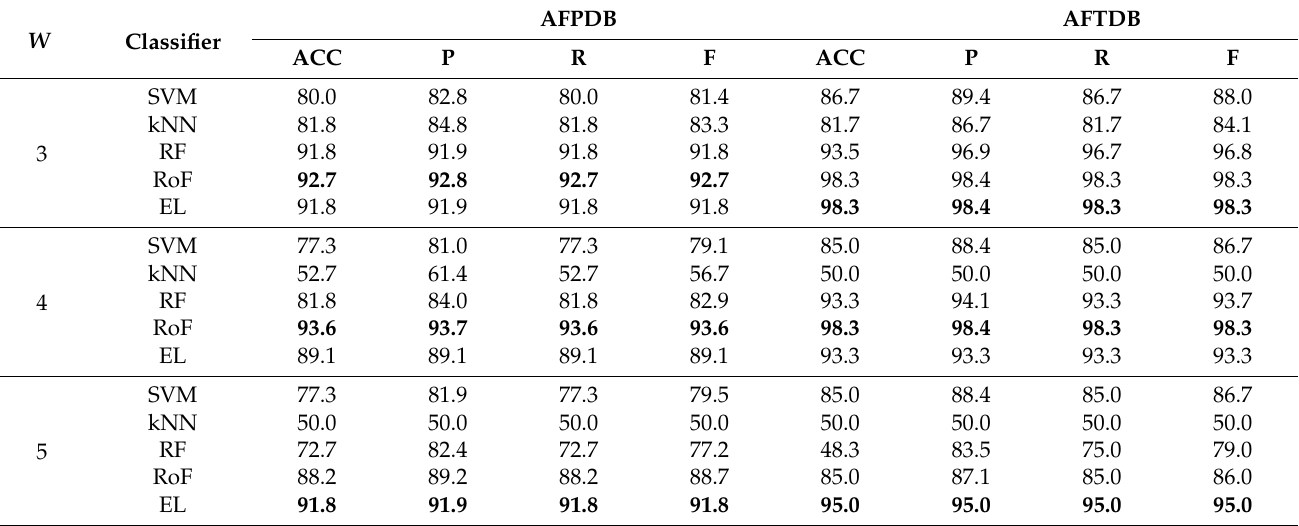
difference of the average DSA feature is greater than 25% for varied W in both AFPDB and AFTDB databases. The smallest and largest difference in the average of DSA feature is observed with W=5 and 3 obtaining 0.122 and 0.526, respectively. Table 4. Overall average performance (%) of the DSA method on the various databases using | V | = 7 with varied W . Bold values indicate the best performance in a group.